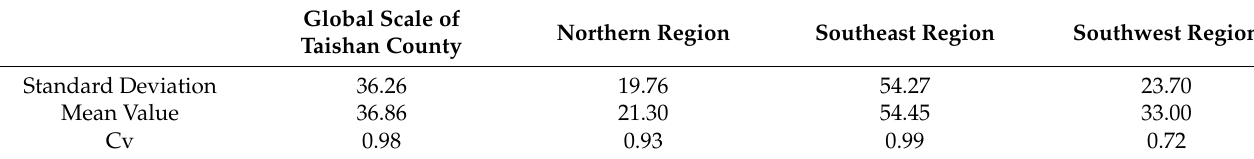
Figure 2. A Voronoi diagram showing the distribution of market towns in Taishan. Light blue part indicates the northern region, light red part indicates the southeastern region, and light green part indicates the southwestern region. Table 1. Summary of the measurements of the Cv.